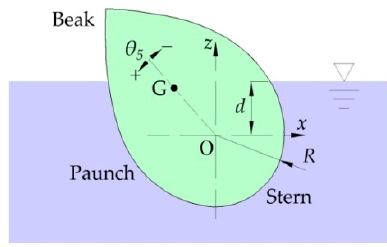
Figure 2. Geometry of the cross section of the solo Duck.